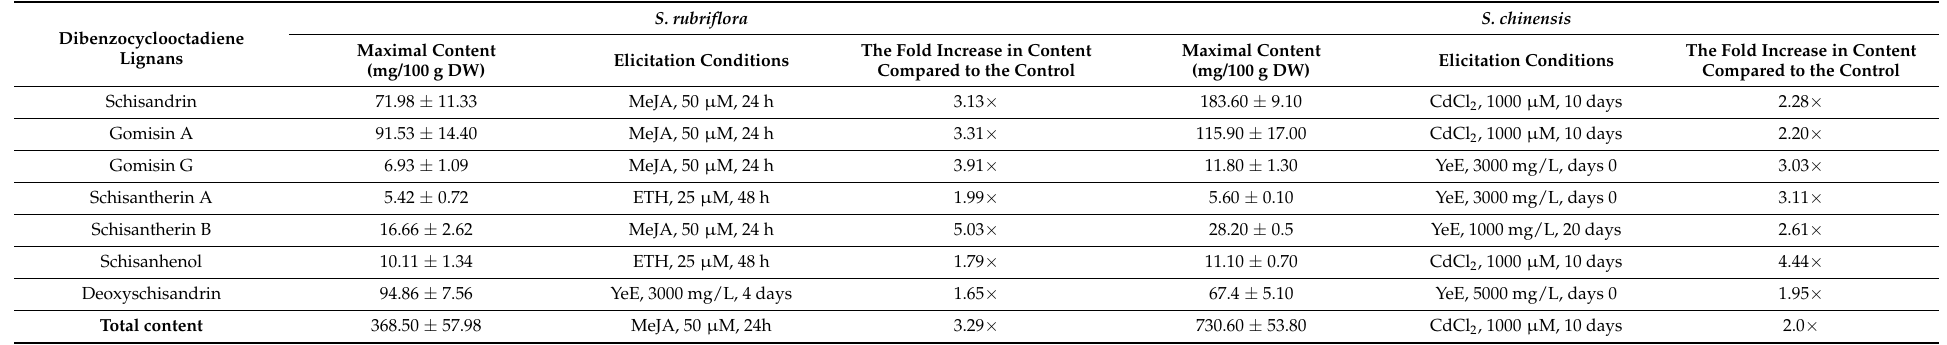
Table 7. Comparison of dibenzocyclooctadiene lignans content and elicitation conditions in microshoot, agitated in vitro cultures of S. rubriflora and S. chinensis species